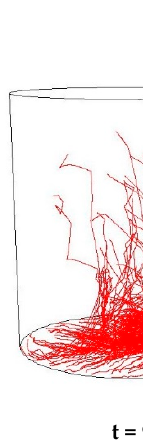
Figure 13. Trajectories of non-metallic Al 2 O 3 inclusions for the case of argon flow of 50 L/min for the particle diameters of ( a ) 18 µ m and ( b ) 27 µ m in the 42CrMo4 steel.